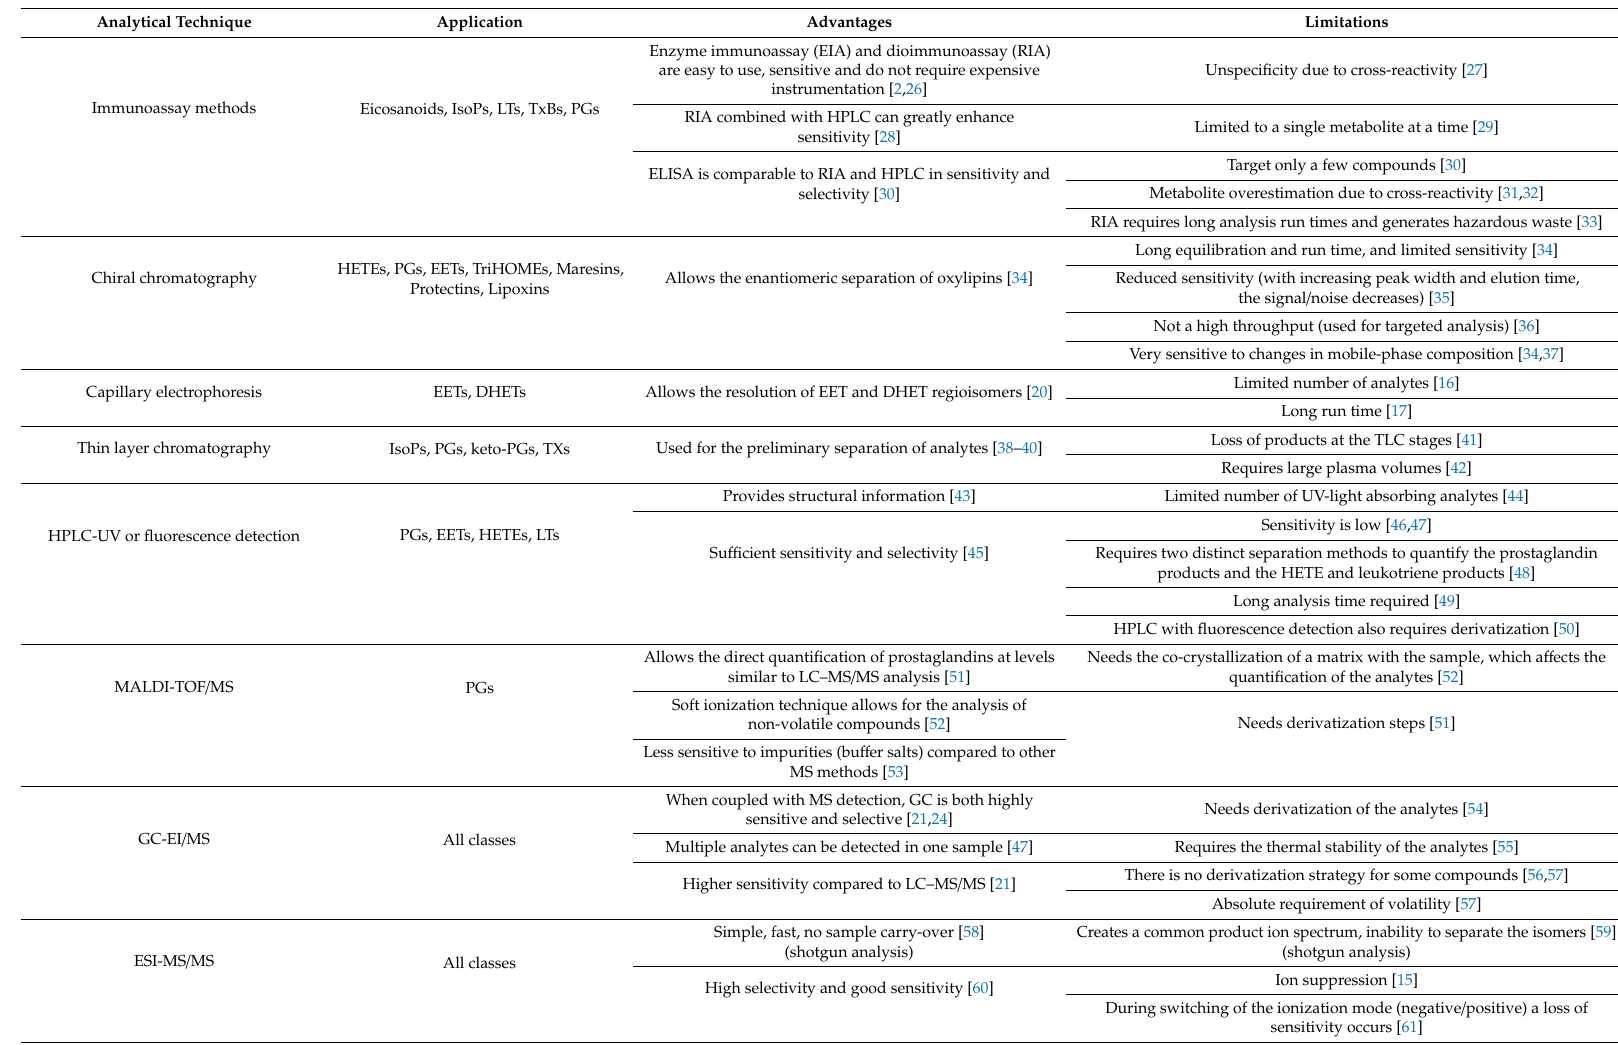
Table 1. Advantages and limitations of the most frequently used analytical methods in the analysis of